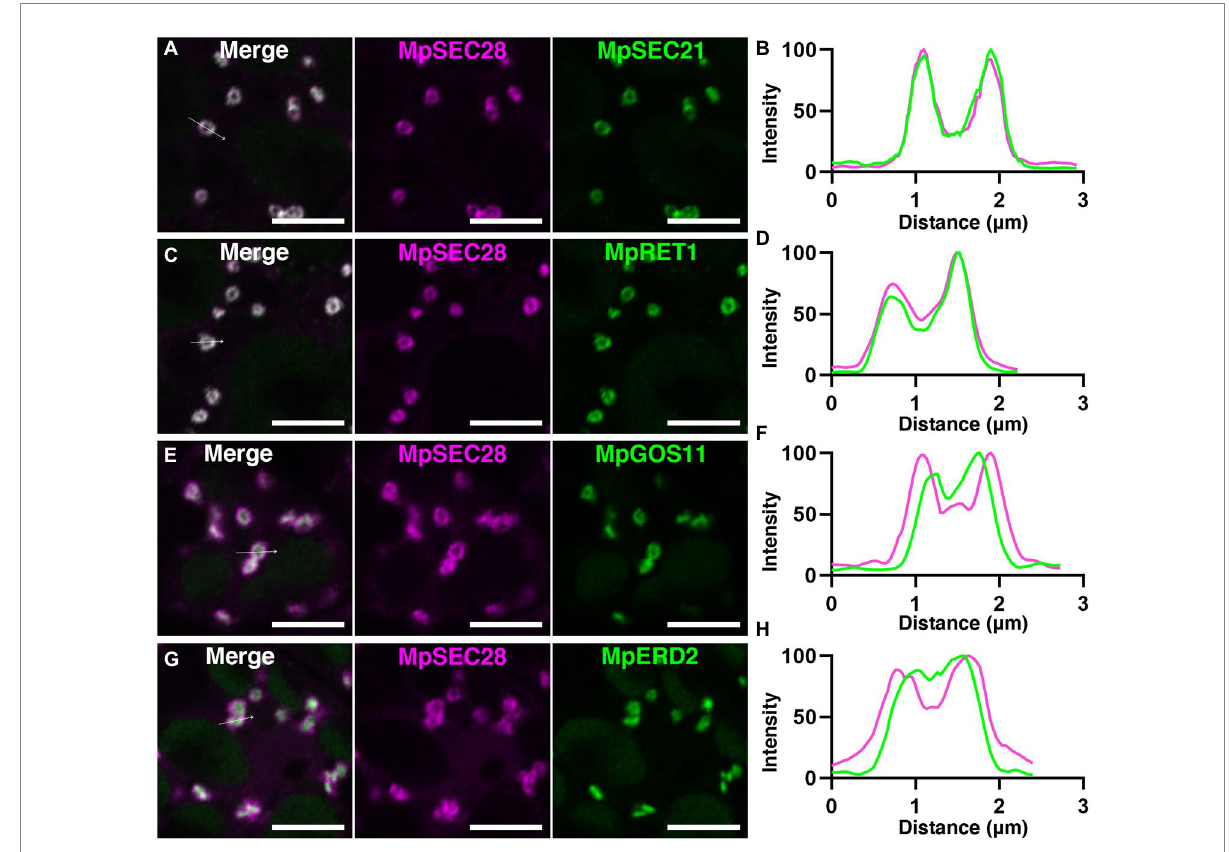
FIGURE 5 Golgi-periphery localization of MpSEC28-mCherry. (A,C,E,G) High spatial resolution images of M . polymorpha thallus cells expressing MpSEC28- mCherry and MpSEC21-mCitrine (A) , MpRET1-mCitrine (C) , mCitrine-MpGOS11 (E) , or MpERD2-mCitrine (G) . Magenta and green pseudo-colors indicate fluorescence from mCherry and mCitrine, respectively. Autofluorescence from chlorophyll in chloroplasts was also detected in the channel of mCitrine. Bars = 5 μ m. (B,D,F,H) Line graphs showing relative fluorescence intensities from mCitrine and mCherry along the white arrows in A (B) , C (D) , E (F) , and G (H)